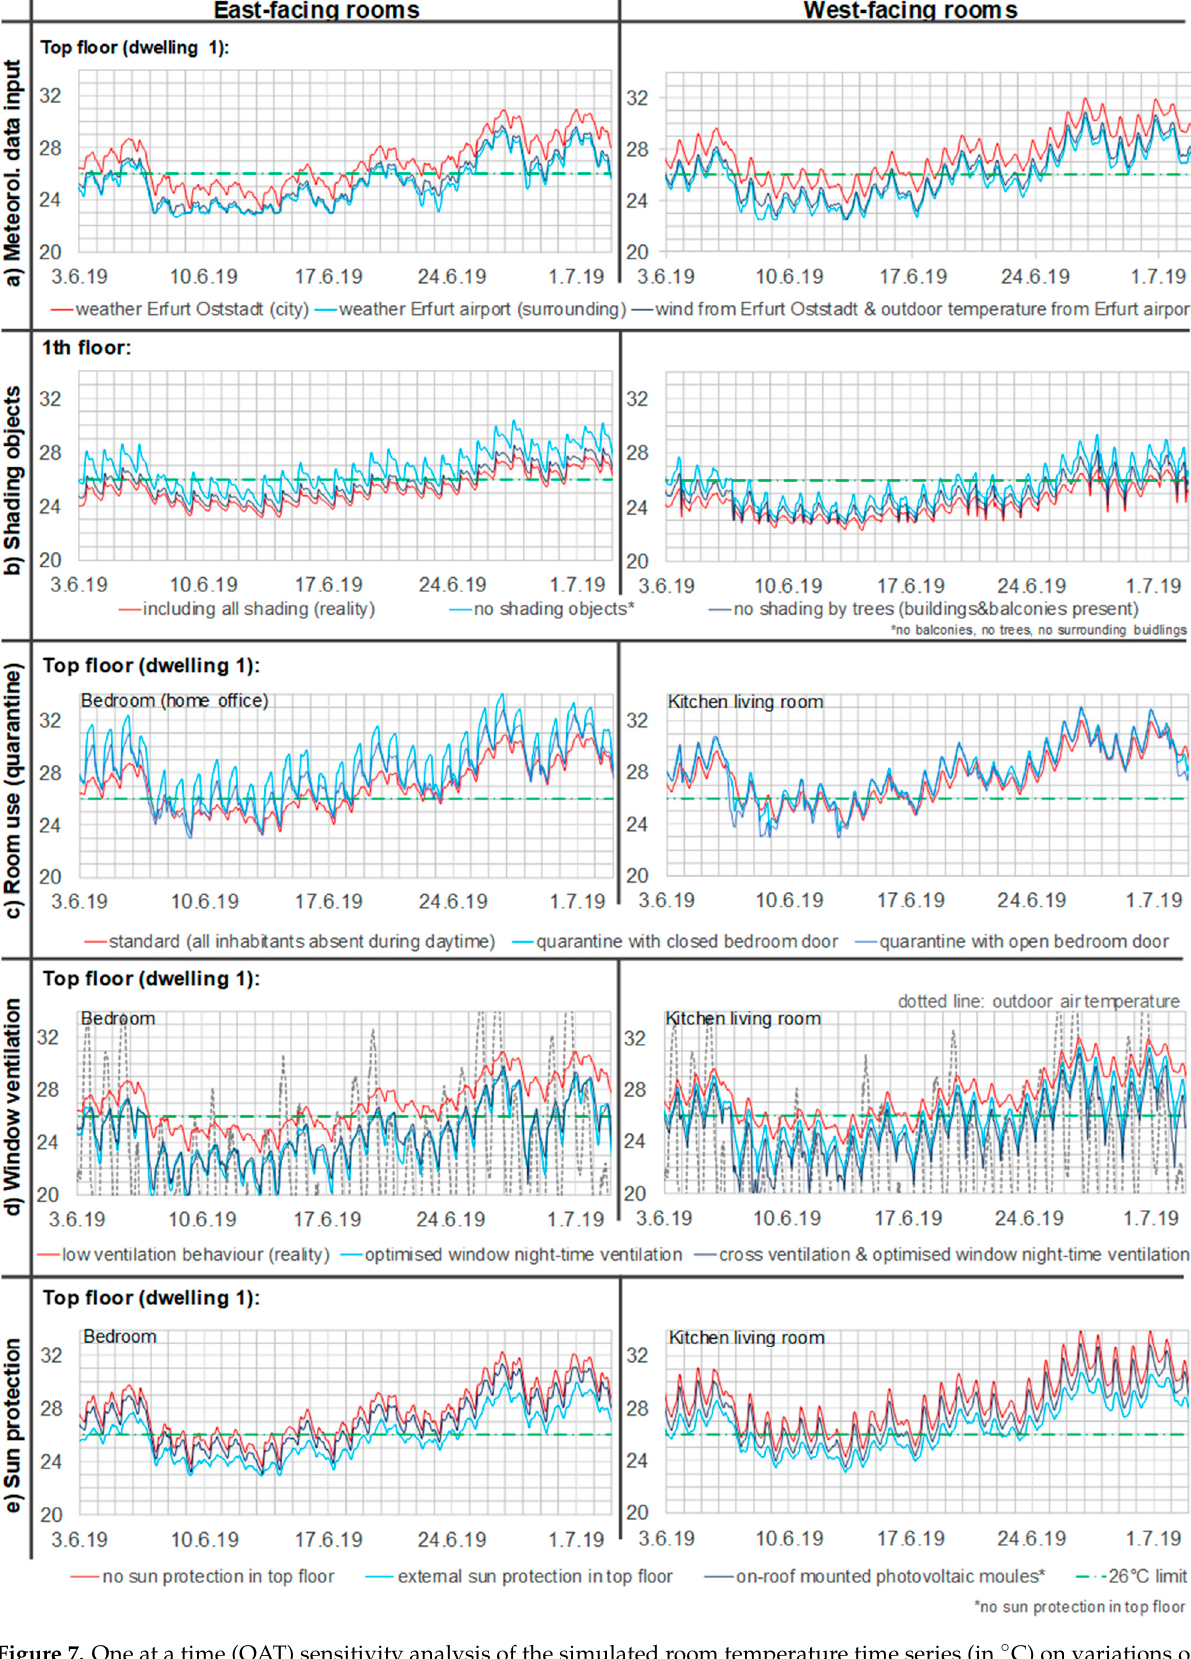
Figure 7. One at a time (OAT) sensitivity analysis of the simulated room temperature time series (in °C) on variations of single parameters for the 1st floor and the top floor dwelling 1.